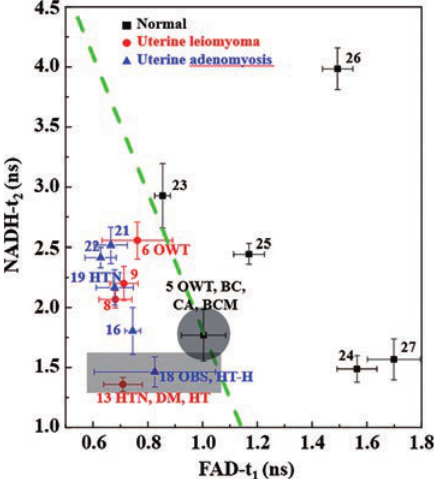
Fig. 6. Di®erentiating benign uterine tumors from healthy uterine group by studying the cervix tissues. The plot t 2 of NAD(P)H versus t 1 of FAD was obtained from 15 patients, whose ages, chronic diseases and medical histories were in Table 1. BC: breast cancer; CA: colon adenomas; BCM: breast cancer metastasis; DM: diabetes mellitus; HT: hyperthyroid- ism; HT-H: hypothyroidism; HTN: hypertension; OBS: obesity; OWT: